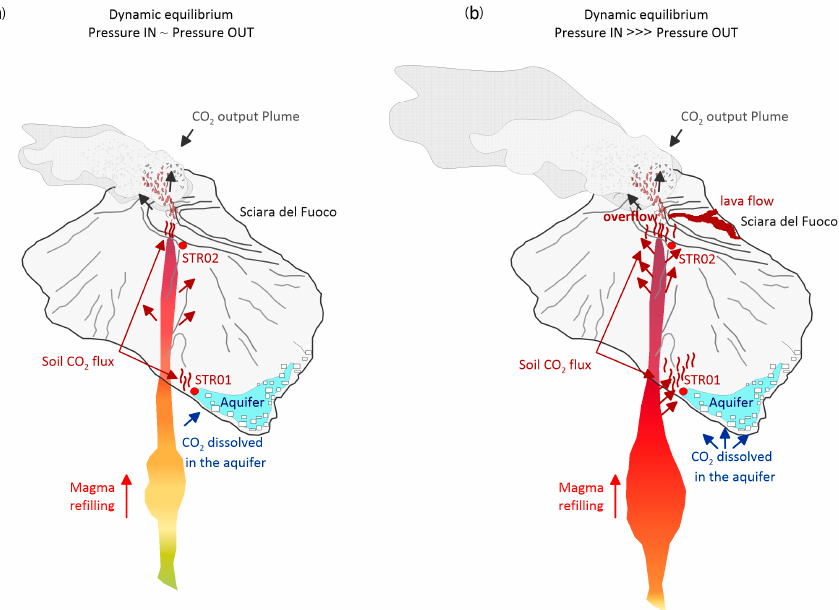
Figure 7. Sketch of the dynamic equilibrium model, modified from [20,23]. ( a ) Normal Strombolian activity. Volatiles exsolved from the magma standing in the deeper plumbing system interact with shallow fluids, feeding the shallow hydrothermal activity and diffuse soil degassing, whose output to the atmosphere maintains the dynamic equilibrium. ( b ) When the deep input considerably increases, the dynamic equilibrium is altered and the shallow system tries to restore it, increasing the outputs.